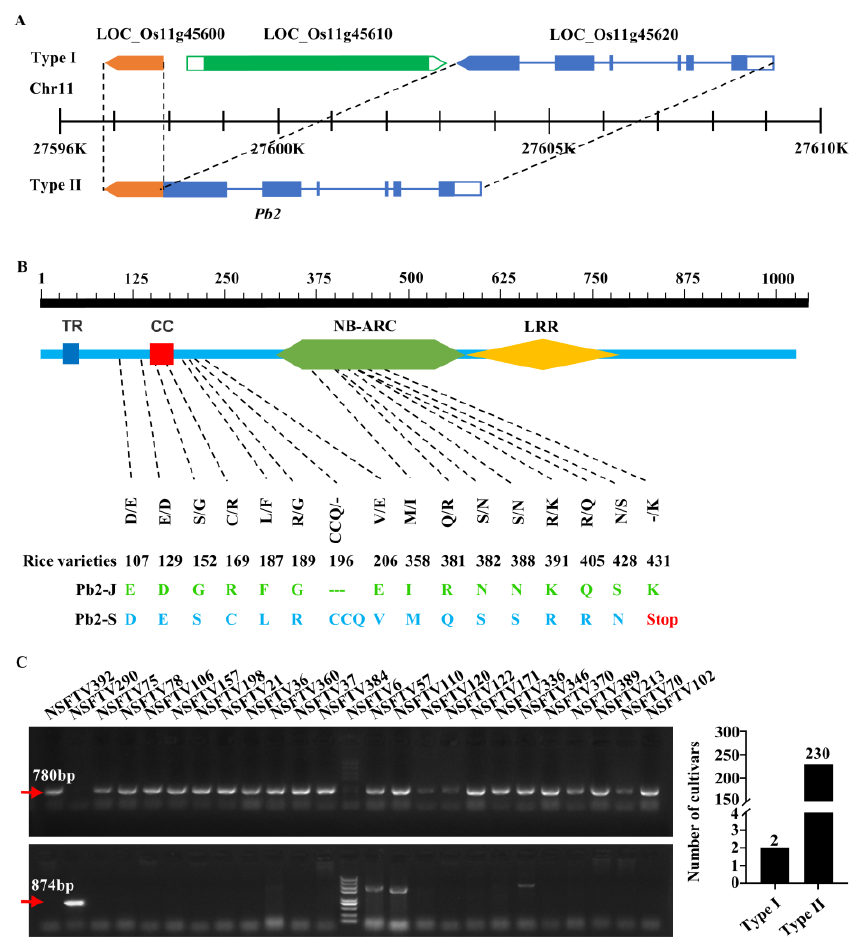
Figure 4. The distribution of Pb2 in natural populations. ( A ) The arrangement of candidate genes on chromosome 11 in different materials. There are two arrangements: Type I, 3 genes are arranged in sequence, LOC_Os11g45600 is shown in orange, LOC_Os11g45610 (retrotransposon) is shown in cyan and LOC_Os11g45620 is shown in dark blue; Type II, there is no LOC_Os11g45610, and LOC_Os11g45600 is the last exponent of LOC_Os11g45620; the combined gene was named Pb2 . Ar- rows indicate gene orientation, blank boxes indicate UTRs and thin lines indicate introns. ( B ) Amino acid sequence and domain analysis of Pb2 in resistant material Jiangnanwan and susceptible mate- rial Suyunuo. Pb2-J : Pb2 cloned from Jiangnanwan. Pb2-S : Pb2 cloned from Suyunuo, translation terminated early. TR: transmembrane domain. CC: coiled-coil. NB-ARC: nucleotide binding region of resistance protein. LRR: leucine-rich repeat. ( C ): The arrangement of Pb2 on chromosome 11 in 232 materials. When only 45600-F/45620-R can amplify the target fragment of 780 bp, it means that there is no LOC_Os11g45610 (top left); when only 45610-F/45620-R can amplify the target fragment of 874 bp, it means that LOC_Os11g45610 is contained (bottom left). On the right are two types of statistics. 2.5. Specific Expression Analysis of Pb2 Intracellular localization of Pb2 was detected by observing the root tip cells of the P Pb2 ::RFP-Pb2 fusion transgenic plants, and it was found that Pb2 was mainly localized on the plasma membrane (Figure 5A). The expression of Pb2 was induced after being inocu- lated by blast fungi at the booting stage, but Pb2-J in resistance cultivar Jiangnanwan was induced more obviously than in the susceptible cultivar Suyunuo (Figure 5B). In addition, Pb2 was specifically expressed in coleoptiles, stem nodes, leaf tips and grains by GUS staining of P Pb2 ::Pb2-GUS transgenic plants (Figure 5C).